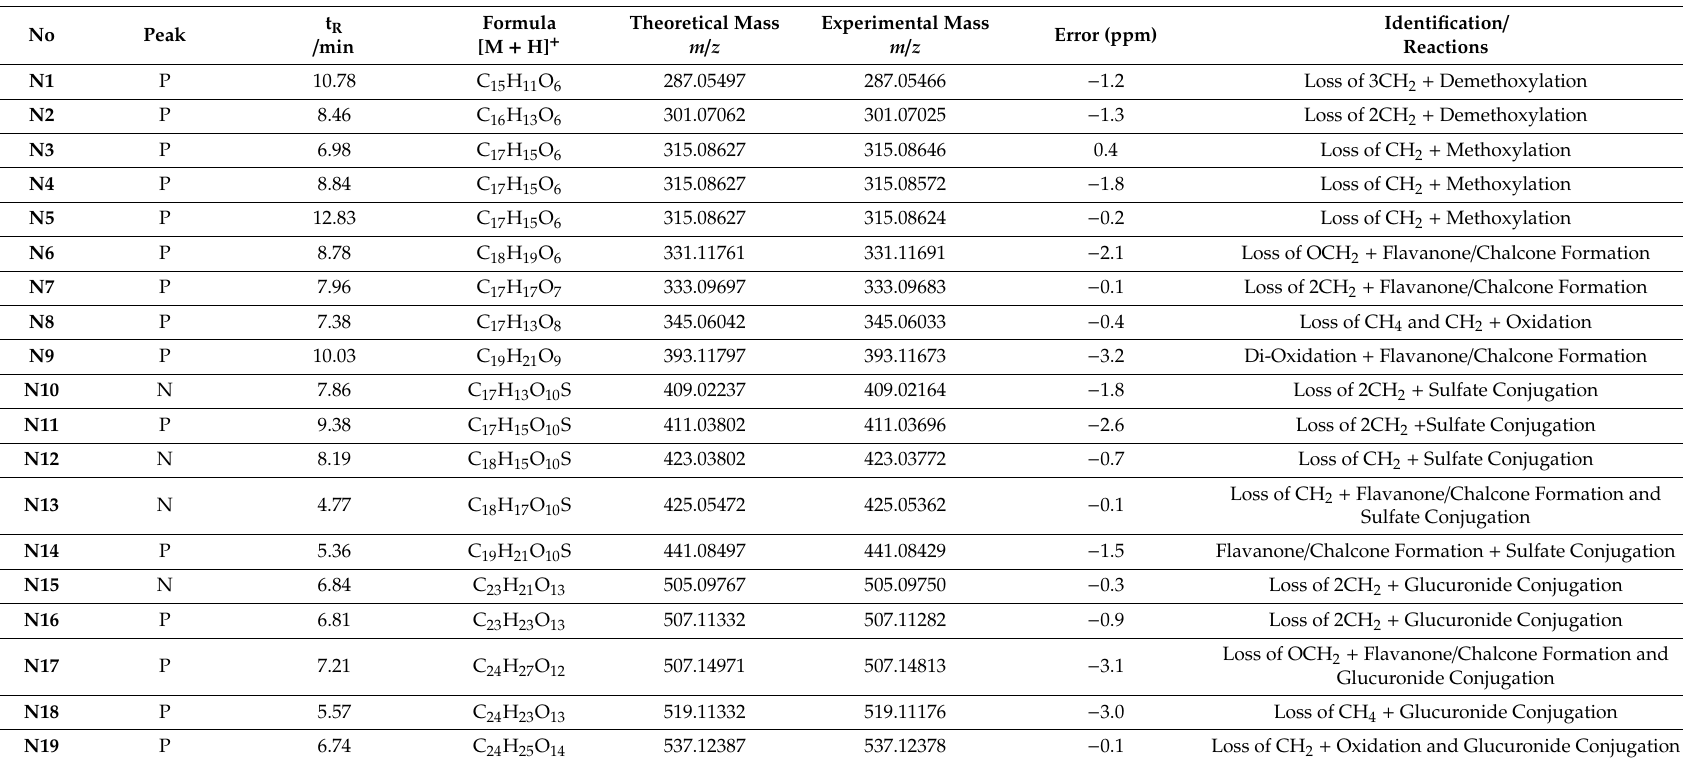
Table 3. Identification of HTF potential metabolites in rat urine and